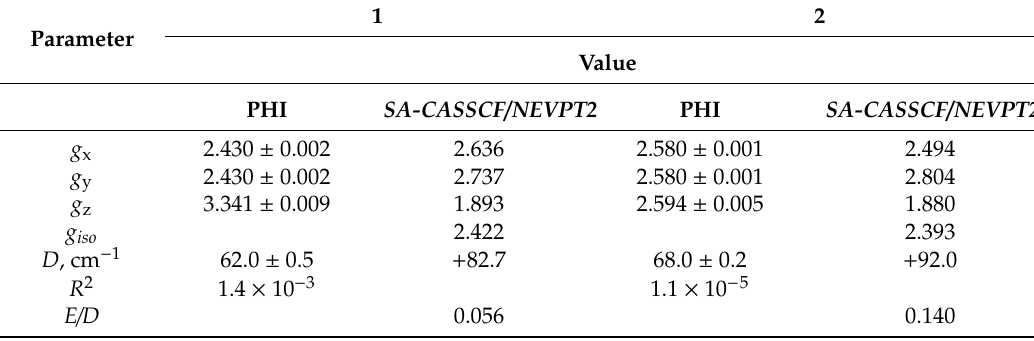
Figure 4. Co(II) ion d-AO splitting pattern in 1 ( left ) and 2 ( right ) according to AILFT analysis (at SA-CASSCF/NEVPT2 level of theory).